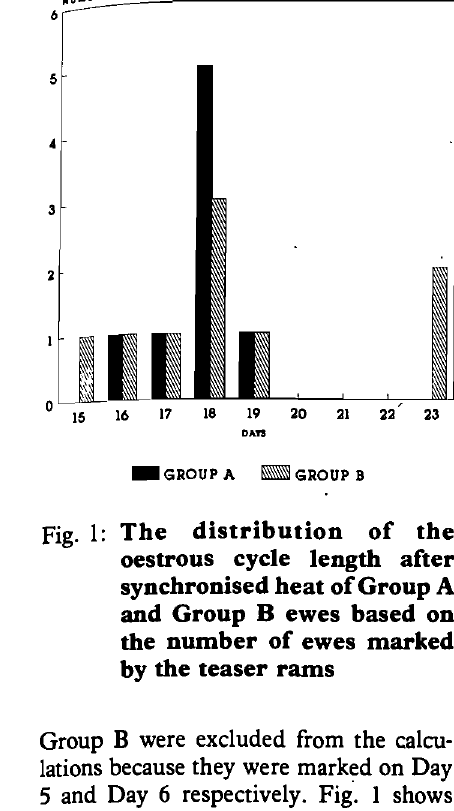
groups. The mean oestrous cycle length